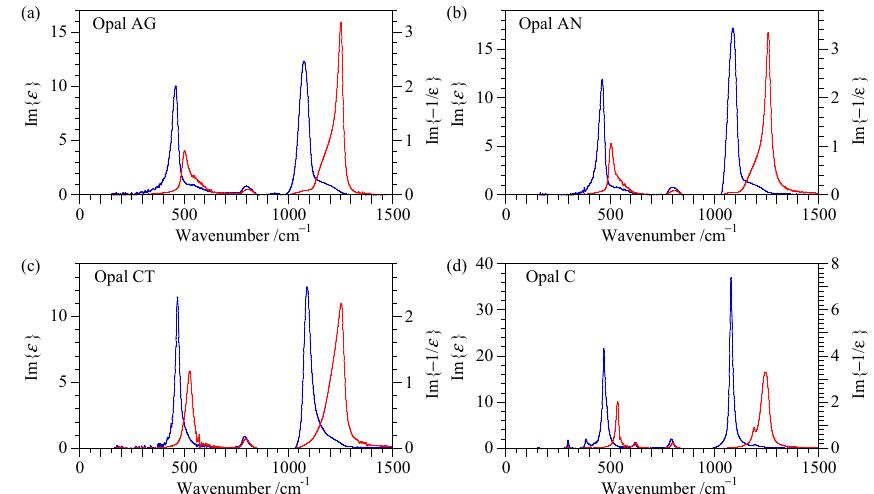
Figure 7. Im{ ε } (blue) and Im{ − 1/ ε } (red) spectra derived from a Kramers-Kronig transform of polished slabs showing TO and LO components, respectively. Samples are ( a ) opal-AG (CP-2 from Coober Pedy, South Australia, Australia), ( b ) opal-AN (MS-1 from mount Squaretop, Queensland, Australia), ( c ) opal-CT (G9942 from Angaston, South Australia, Australia) and ( d ) opal-C (T1664 from Guanajuanto, Mexico). Note that the Im{-1/ ε } spectrum is displayed 5× enhanced compared to the Im{ ε } spectrum. Im{ ε } values are given on the left axis and Im{ − 1/ ε } values are displayed on the right axis.